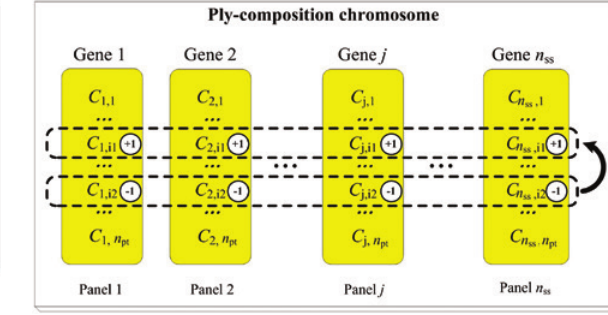
Figure 9: Swapping operations in a ply-composition chromosome.